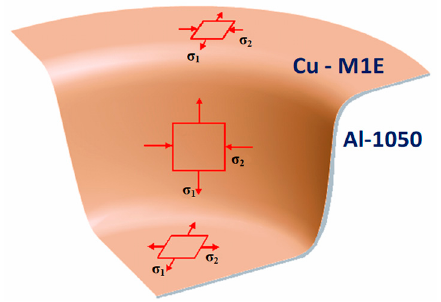
Figure 1. Diagram of the main stresses state during stamping of a drawpiece. Based on [2,5,6].